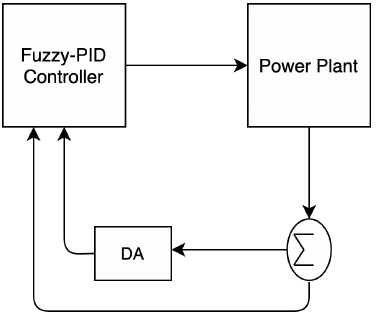
Figure 7. Optimization of fuzzy PID controller using DA